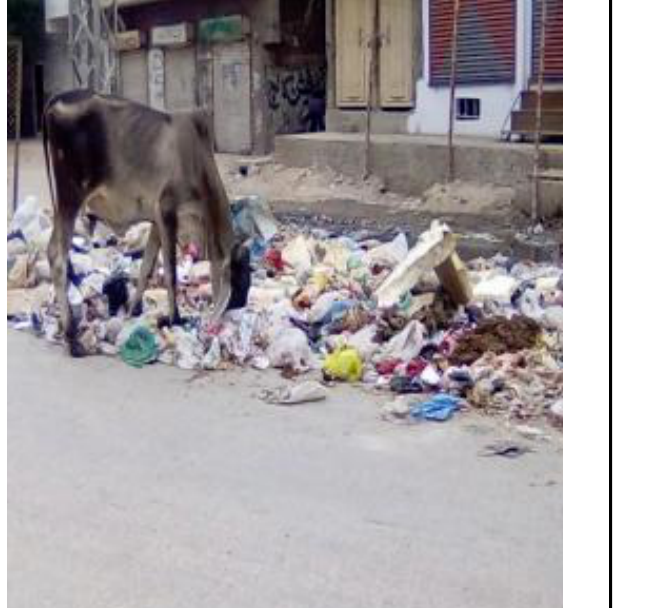
FIG. 3. LATIFABAD UNIT-6, THE POOR STATE OF WASTE AT MAIN ROAD